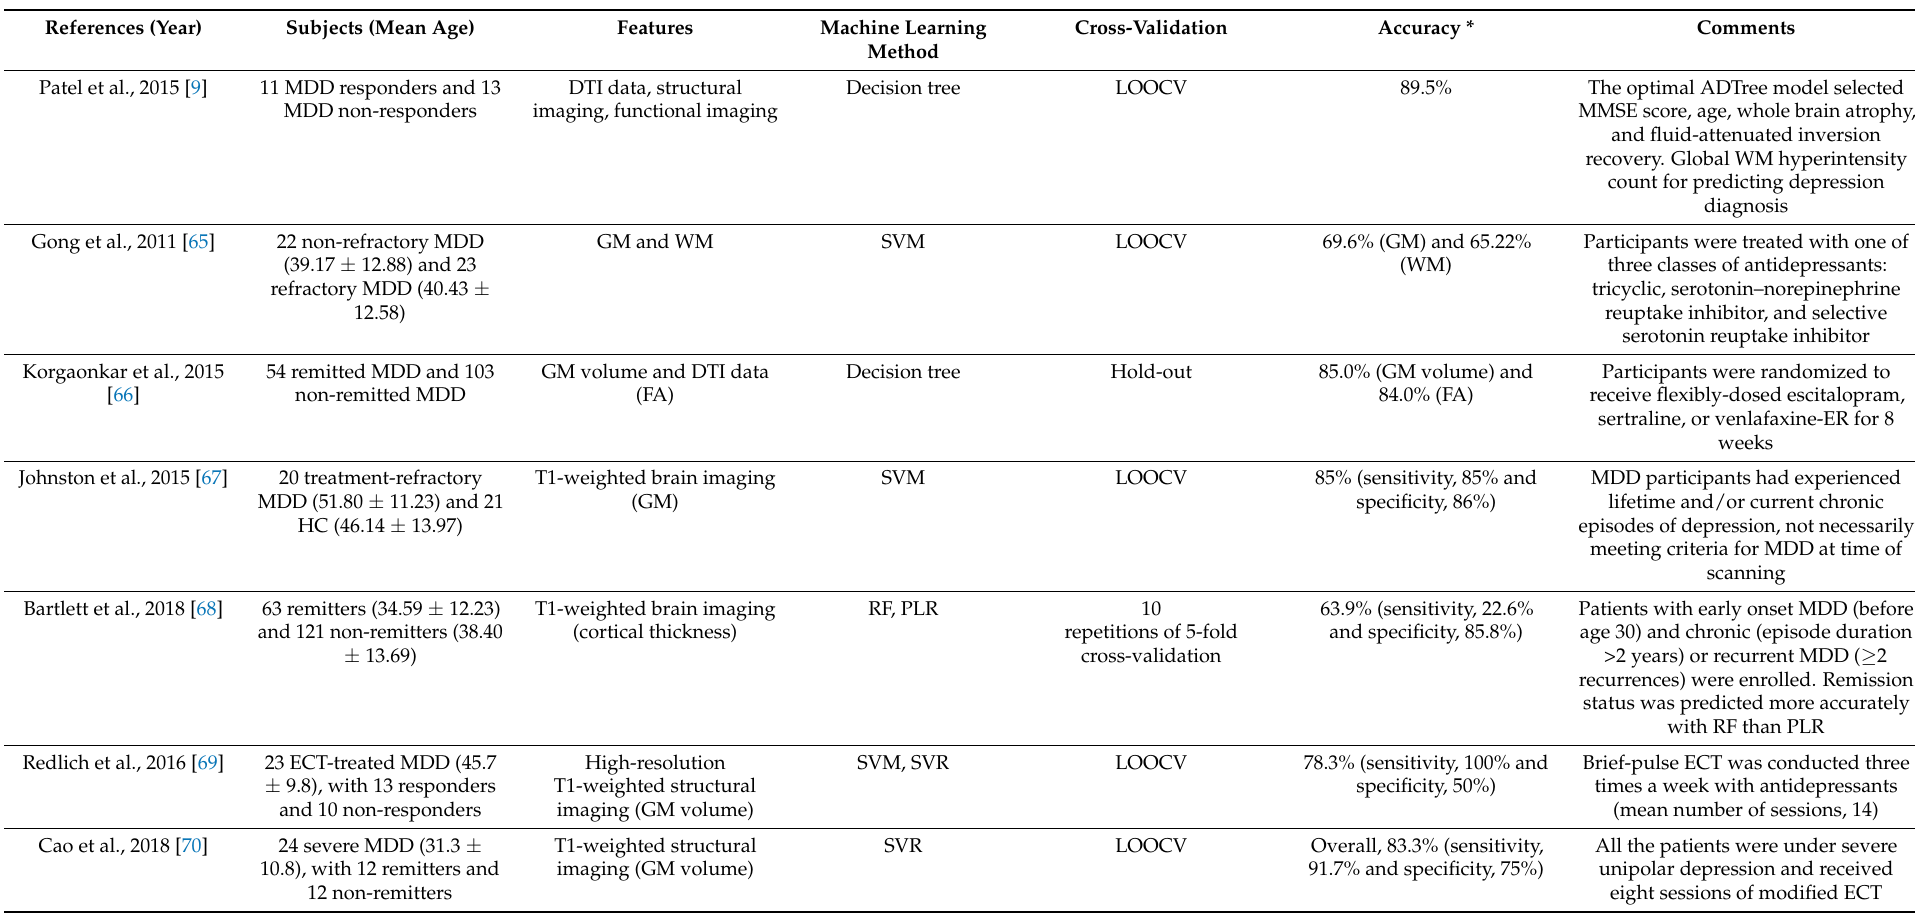
Table 2. Selection of studies investigating machine learning methods for the prediction of treatment outcomes in